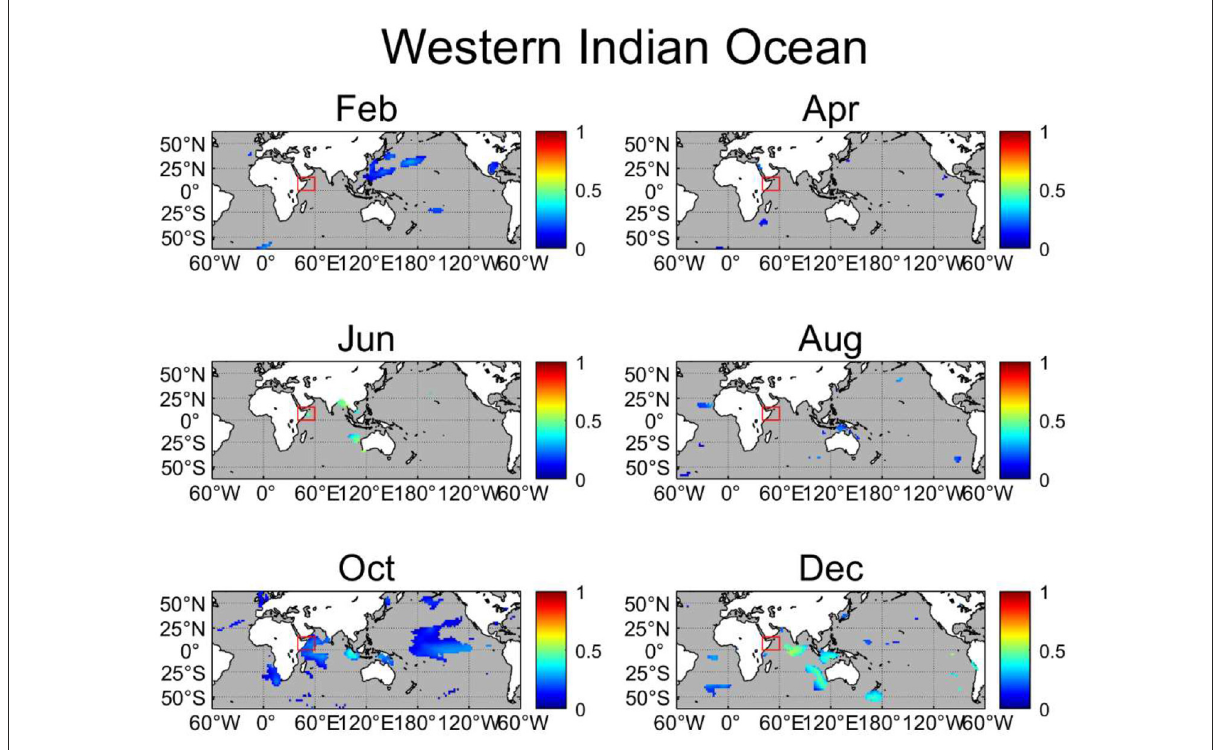
FIGURE11 As in Figure 8, but for the northwestern tropical Indian Ocean (40–60 ◦ E, 0 ◦ -15 ◦ N).